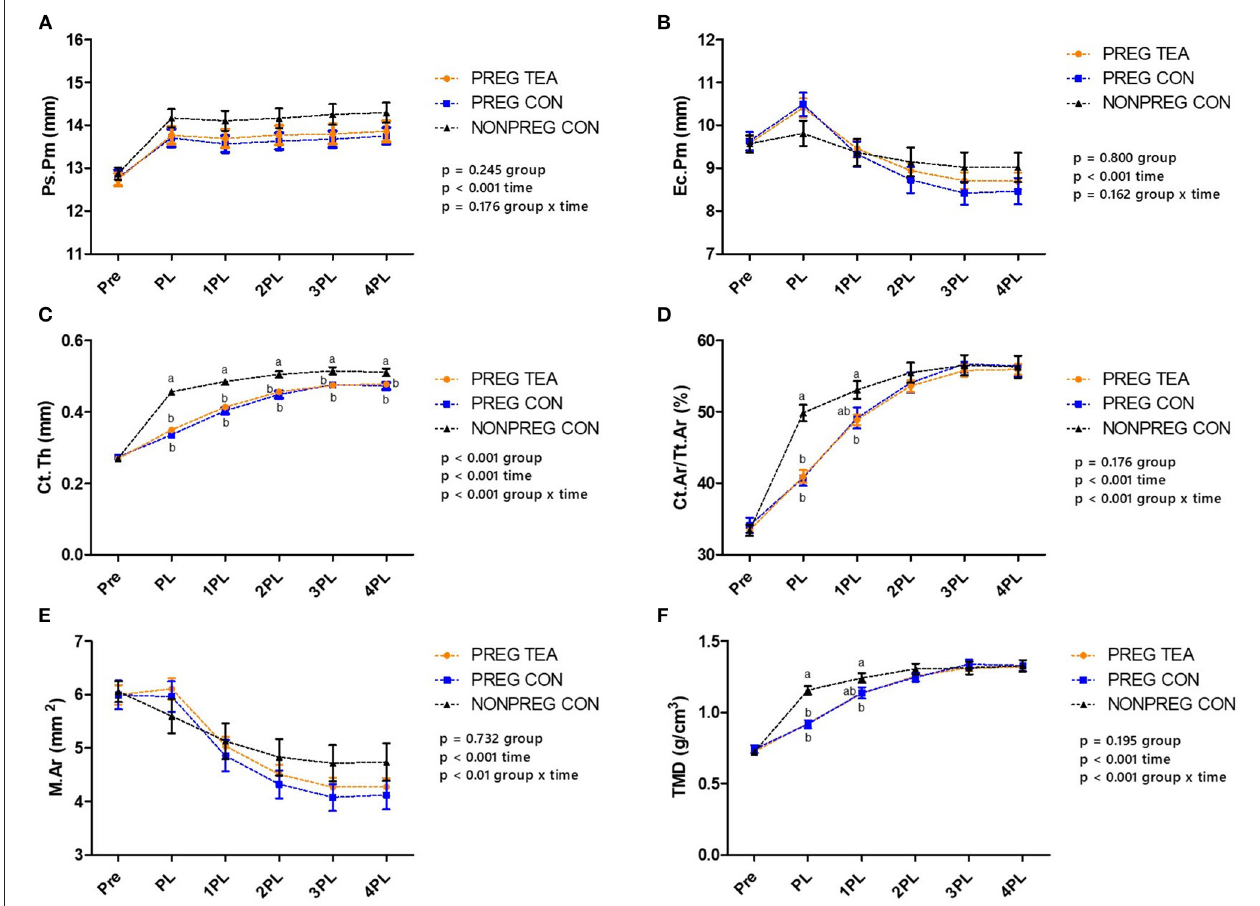
FIGURE 6 | Comparison of cortical bone outcomes between PREG TEA, PREG CON, and NONPREG CON; (A) Ps.Pm, (B) Ec.Pm, (C) Ct.Th, (D) Ct.Ar/Tt.Ar, (E) M.Ar, and (F) TMD. Values are mean ± SEM, n = 13 or 14/group. Differing letters denote a significant difference among groups within a time point. Pre: pre-pregnancy, PL, post-lactation; 1PL, 1 month post-lactation; 2PL, 2 months post-lactation; 3PL, 3 months post-lactation; and 4PL, 4 months